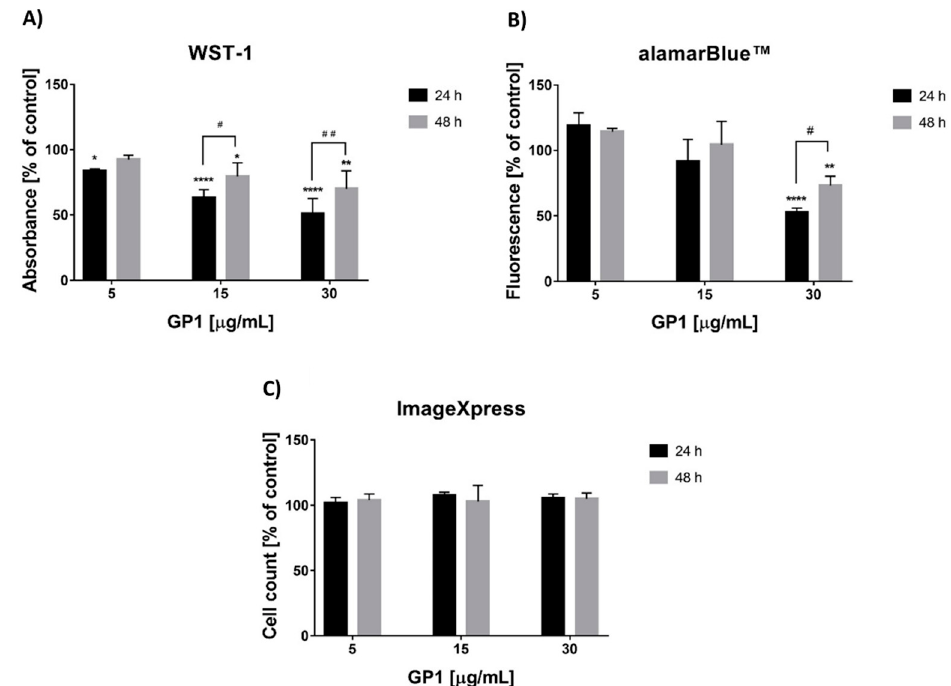
Figure 1. Effect of GP1 at concentrations of 5, 15 and 30 µg/mL on A549 cells during 24 h and 48 h as measured by cell metabolic assay—( A ) WST-1, ( B ) cell metabolic assay—alamarBlue TM , ( C ) cell count performed on ImageXpress—IMEX. Data (optical density, cell count) represent the mean expressed as percentage of control (0 mM) ± SD of the three independent experiments. Statistical significance was evaluated with Two-way ANOVA Dunnett’s multiple comparisons test. Statistically significant decrease of values compared to controls * p < 0.05, ** p < 0.01, *** p < 0.001, **** p < 0.0001. Statistically significant difference between two incubation times within one graphene concentration # p < 0.05, ## p < 0.01.